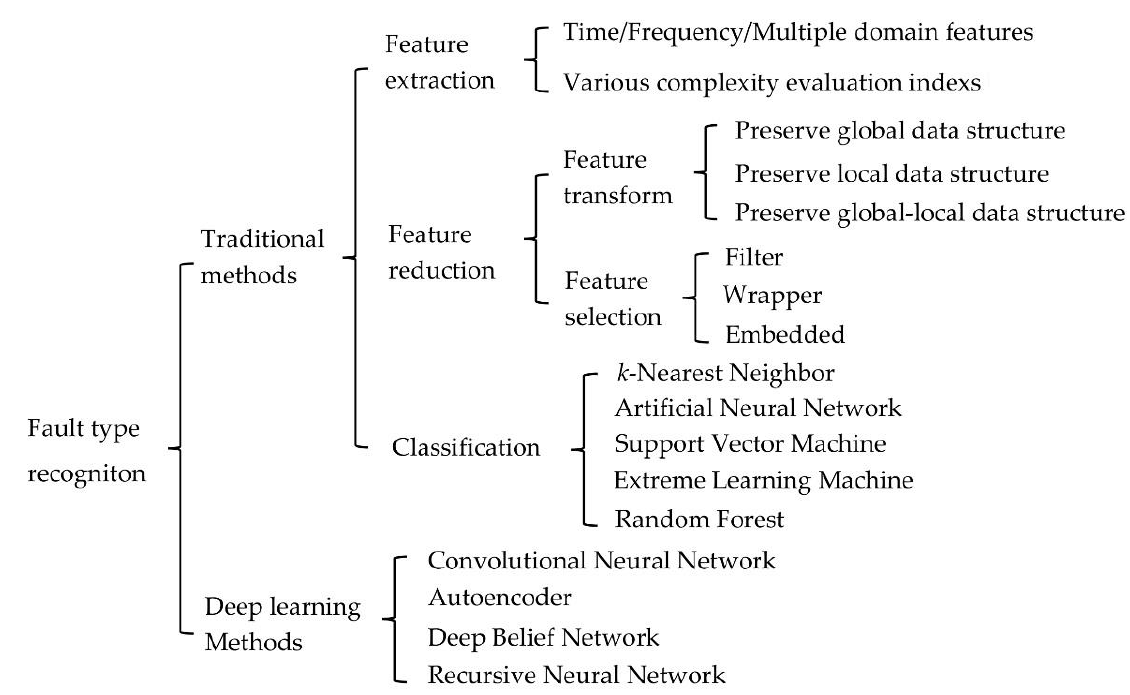
Figure 5. Summary of rolling bearing fault type recognition methods.